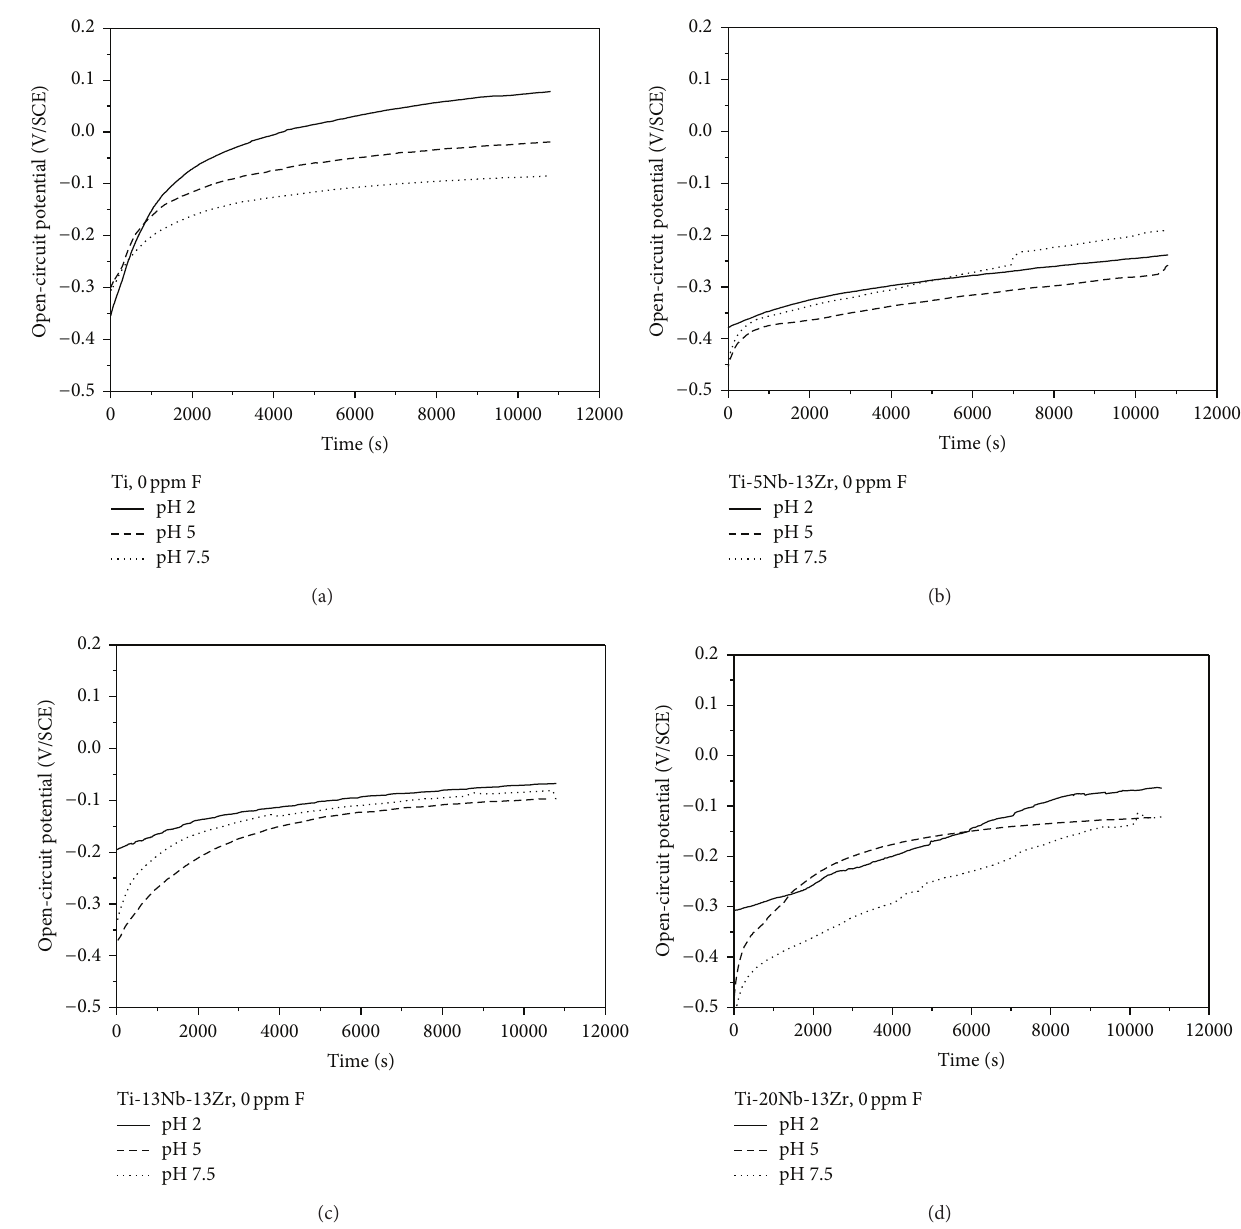
Figure 1: Variation of OCP with exposure time for (a) CP-Ti, (b) Ti-5Nb-13Zr, (c) Ti-13Nb-13Zr, and (d) Ti-20Nb-13Zr in Ringer’s solution of pH 2, 5, and 7.5 at 37 ∘